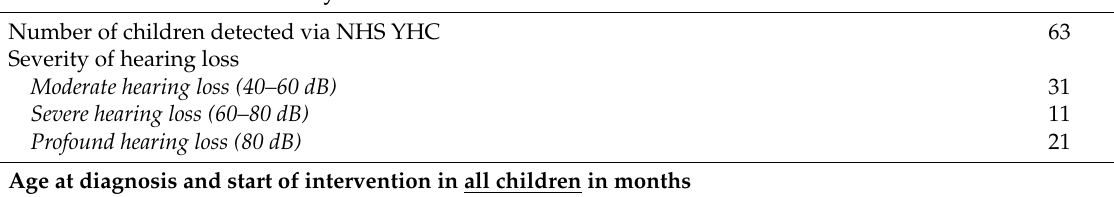
Table 6. Data of the timeliness of early intervention with hearing aids, obtained from the Dutch